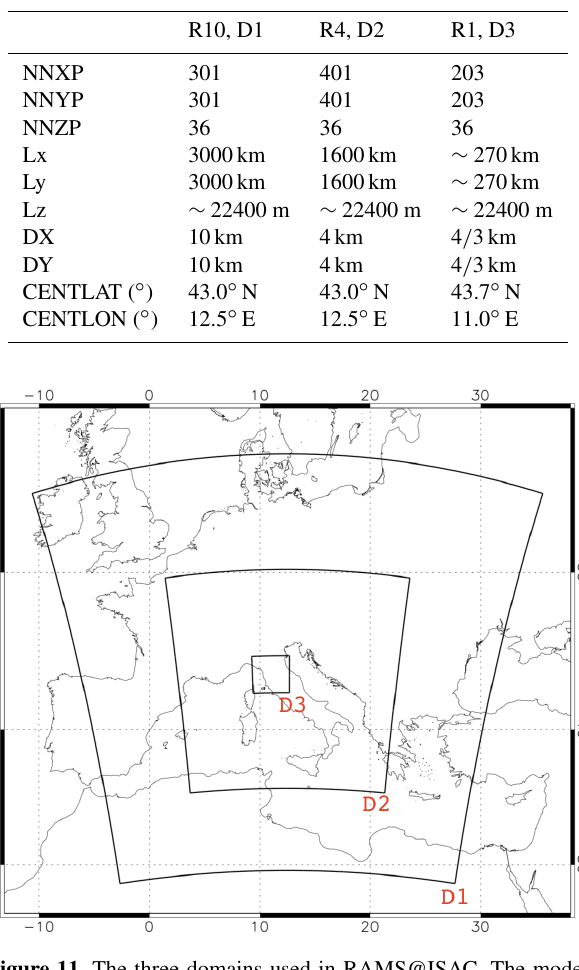
Table 2. Basic parameters of the RAMS@ISAC grids (R10, R4, and R1, corresponding, respectively, to the domains D1, D2, and D3). NNXP is the number of grid points in the WE direction, NNYP is the number of grid points in the NS direction, NNZP is the number of vertical levels, DX is the size of the grid spacing in the WE direc- tion, and DY is the grid spacing in the SN direction. Lx, Ly, and Lz are the domain extensions in the NS, WE, and vertical directions. CENTLON and CENTLAT are the coordinates of the grid centres.